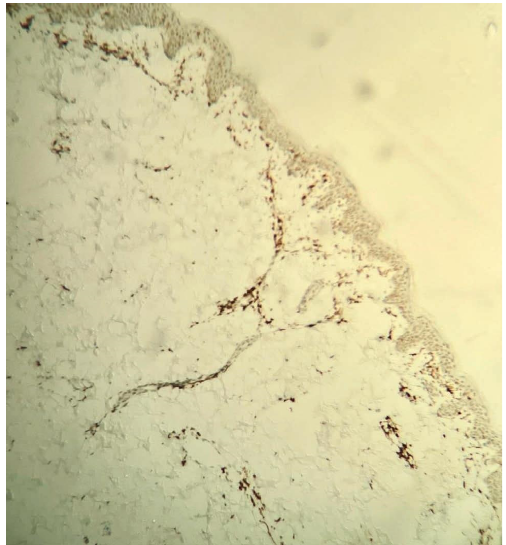
Figure 3: Immunohistochemical staining showing CD 4+ T